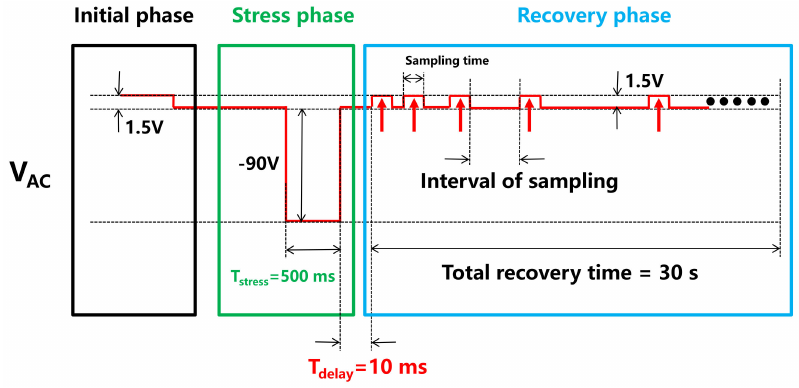
Figure 2. Dynamic measurement test sequence with an STS8200.